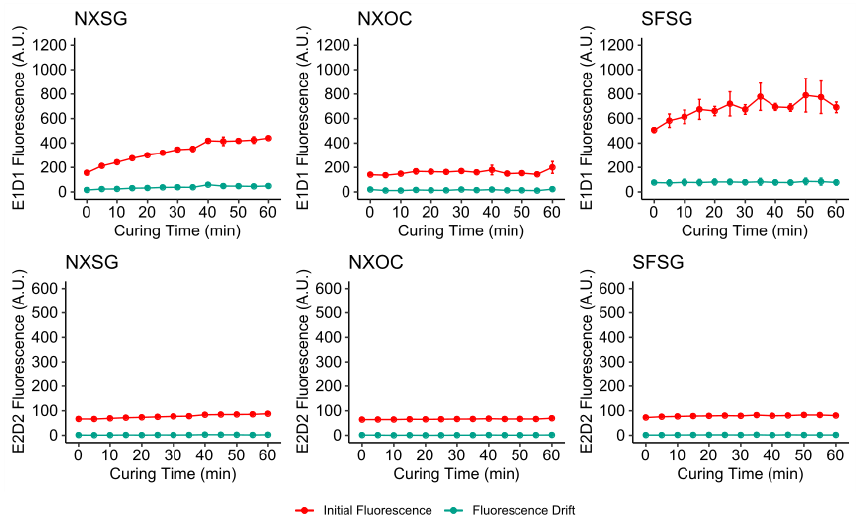
Figure 5. Results of background fluorescence and fluorescence drift measurements for microreactors post cured at room temperature. All measurements were performed on three microreactors for each material.